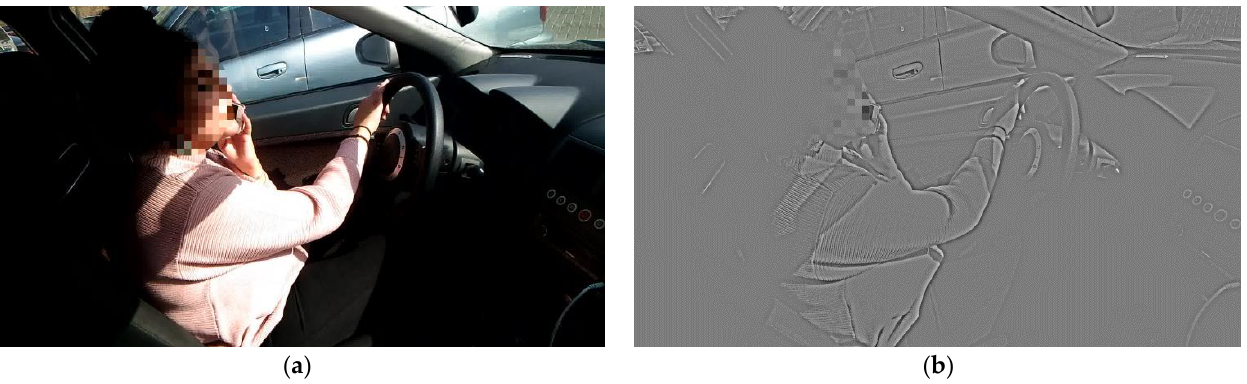
Figure 8. The performance of the subtract mean filter. ( a ) The original image. ( b ) The image after being filtered.